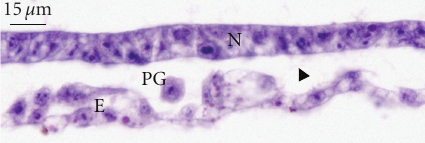
Figure 6: Section through the cranial part of a symmetrically hemisectioned chicken blastoderm after 28 hours of culture; neural plate (N); endophyll (E); PG, primordial germ cell in the neighborhood of the endophyll. Hematoxylin-eosin. Bar = 15 μ m.